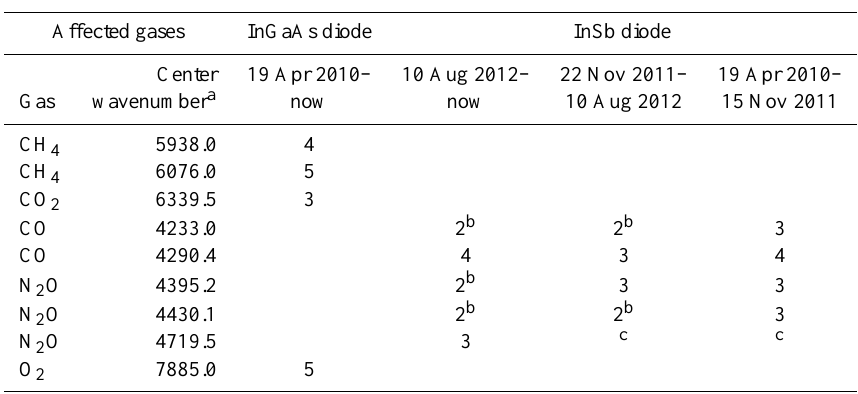
Table 2. Changes for the new Karlsruhe retrieval strategy. Not listed spectral windows will be retrieved by the recommended TCCON retrieval strategy. The three different time periods for the InSb diode correspond to the usage of three different narrowband filters in front of this detector since the instrument was initiated.